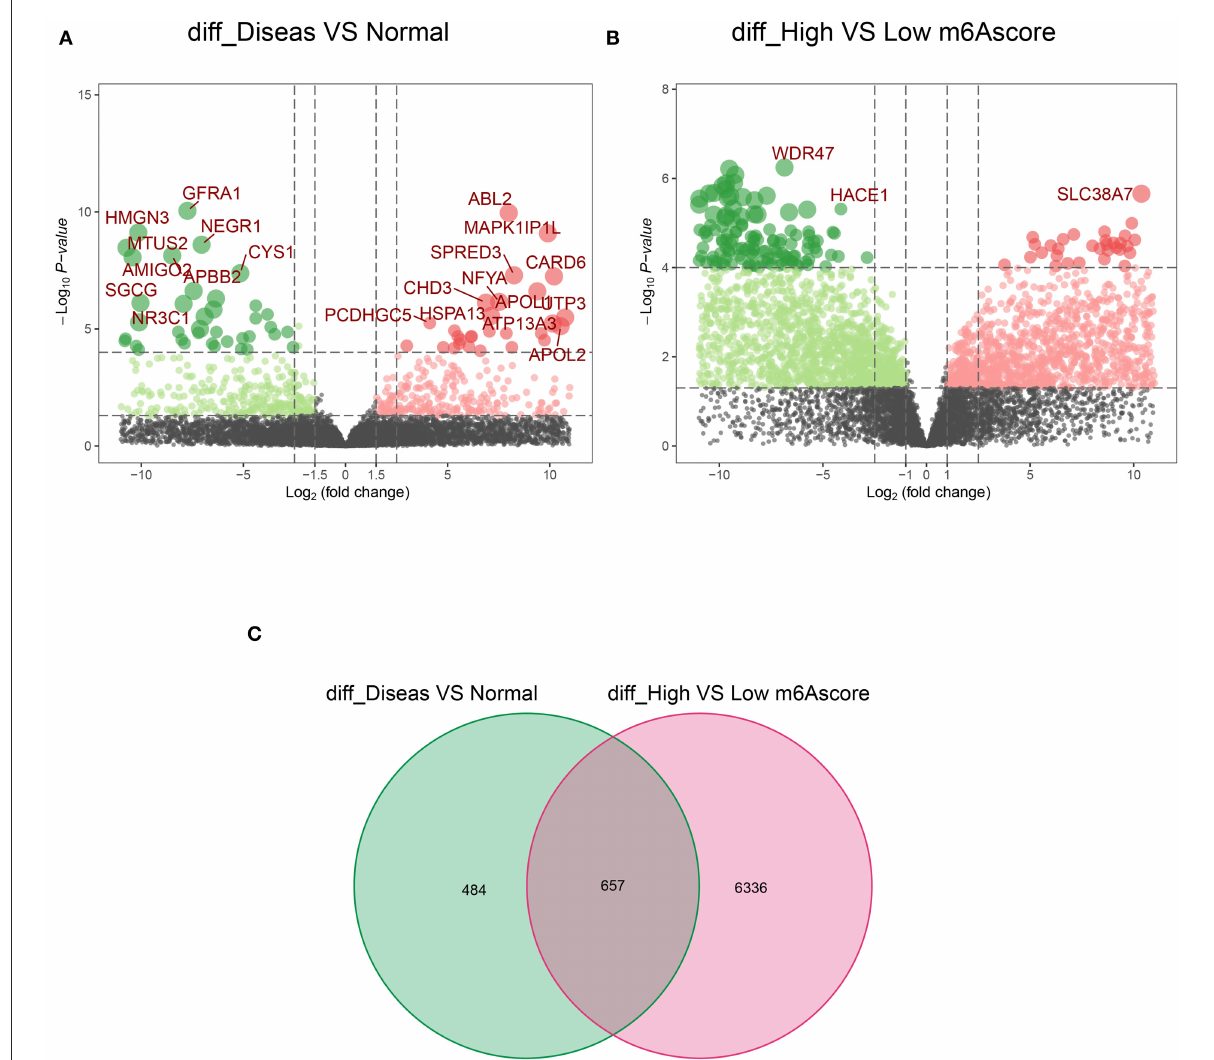
FIGURE7 The acquisition of common 657 differentially expressed genes (DEGs). (A) The volcano plot of 1,141 DEGs in healthy and AD samples. (B) The volcano plot of 7,039 DEGs in the high score and low score m6A groups. (C) A total of 657 common DEGs from A and B in the Venn